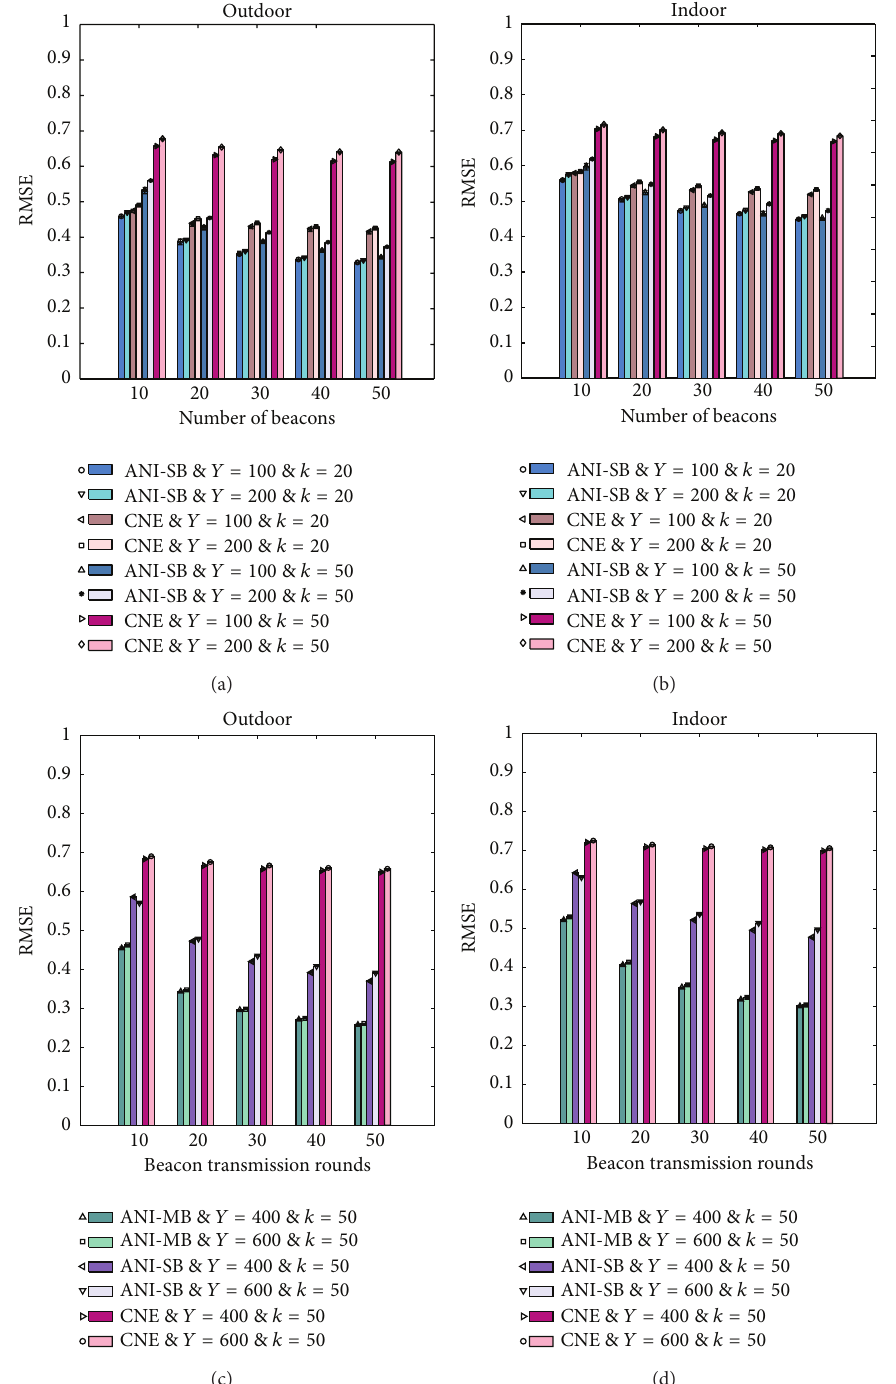
Figure 7: Link quality estimation errors by ANI-SB, ANI-SB, and CNE protocols in multihop topology networks deployed in outdoor and indoor